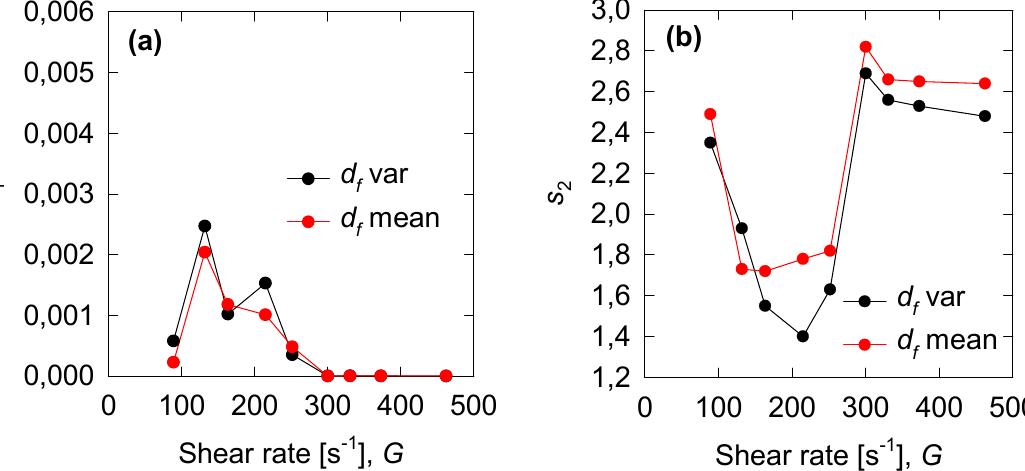
Figure 7. Optimum breakage parameters vs. shear rate for constant and variable fractal dimension, ( a ) s 1 and ( b ) s 2 .